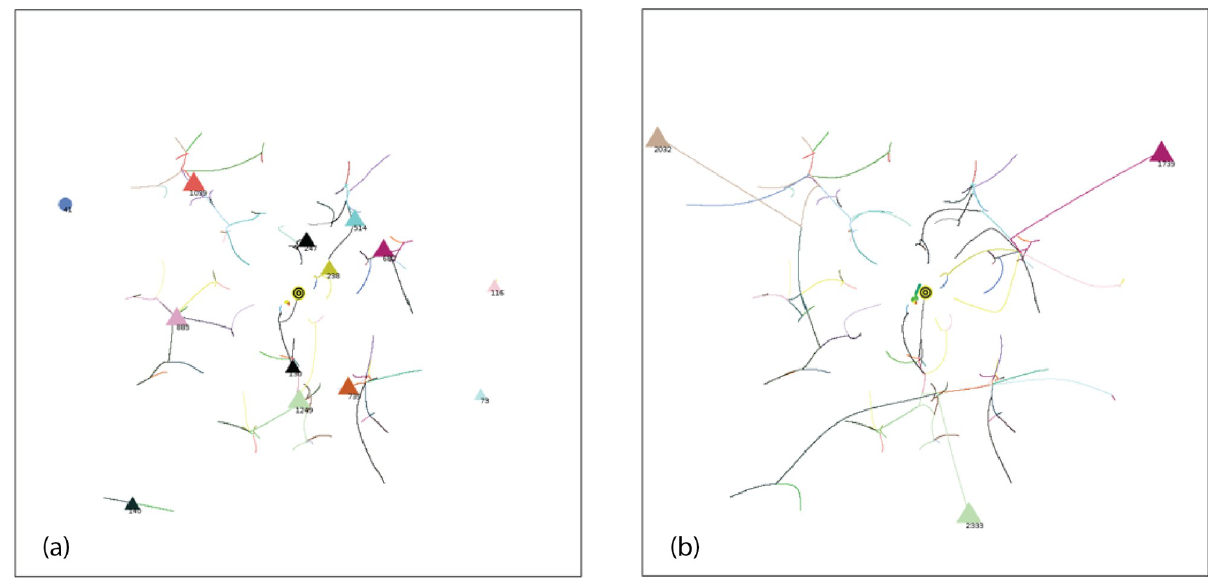
Fig 10. Simulation at 75% of completion. a) AIB = 30, ET = 5116, 12 groups, 1 individual, MDCN = 28, repulsive force < 0.8%, DT < 20. b) AIB = 180, ET = 40,502, 3 groups, MDCN = 154, repulsive force � 100%, DT � 110. For animation of this simulation with AIB = 180 go to https://youtu.be/ BArqDp8-JAQ.